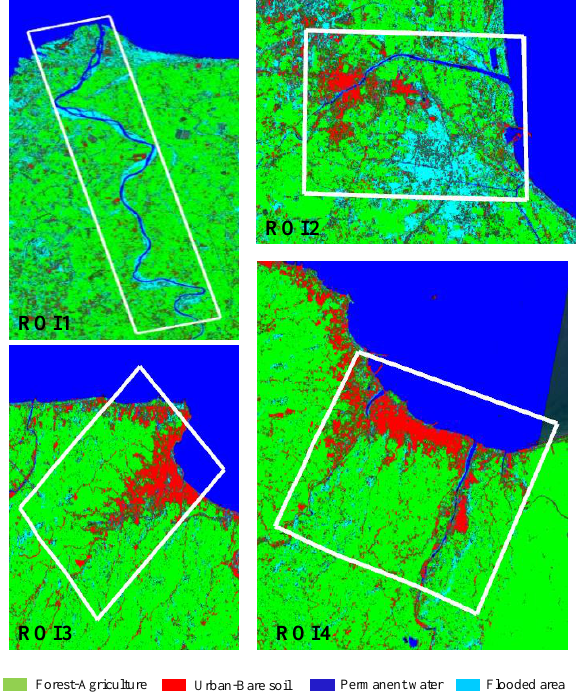
Figure 13. Zoomed views of sub-areas.